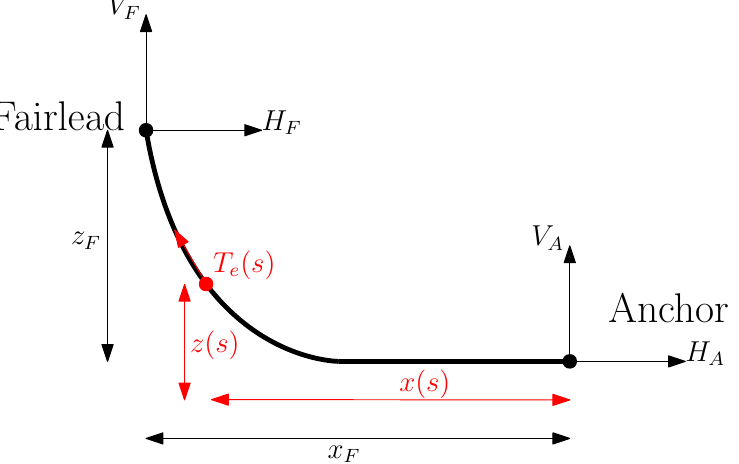
Figure 3. One mooring line representation in 2D for quasi-static